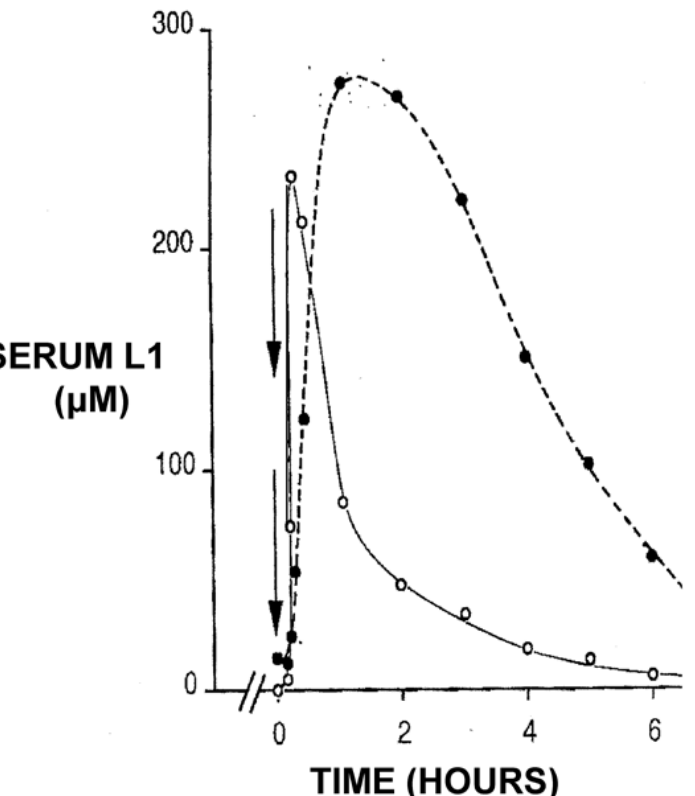
Figure 6. Pharmacokinetic profile of deferiprone (L1) and its glucuronide metabolite conjugate following its oral administration in a thalassemia patient. Deferiprone (L1) 3 g was administered at time 0, which was rapidly absorbed (open circles), peaked within one hour and cleared from the blood in about 6 h. The blood clearance rate of the glucuronide metabolite conjugate (black circles) was slower, as monitored by measuring the absorbance at 280 nm (see [107,170]).